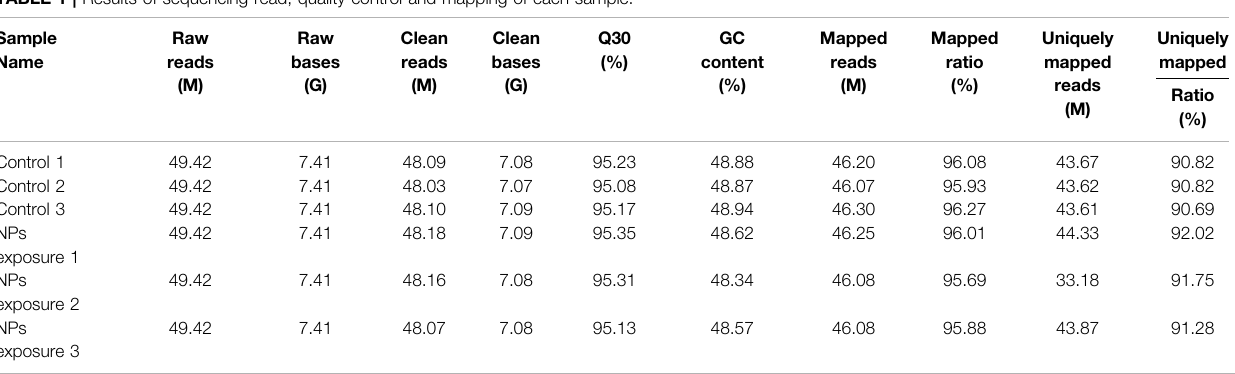
TABLE 1 | Results of sequencing read, quality control and mapping of each